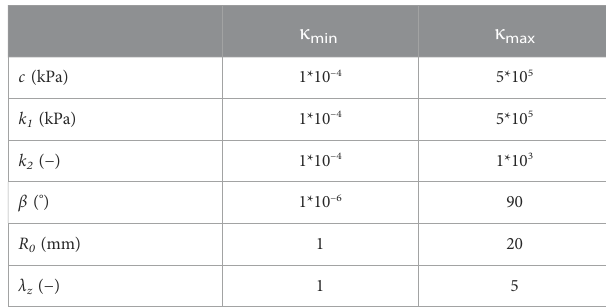
TABLE 1 Fitting ranges of the model